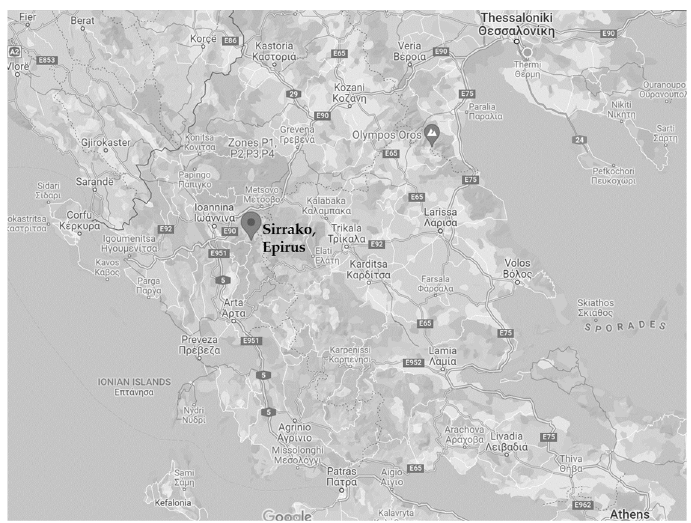
Figure 1. Location of Sirrako village, Epirus, Greece. Source: Google Maps (accessed on 5 Jan- uary